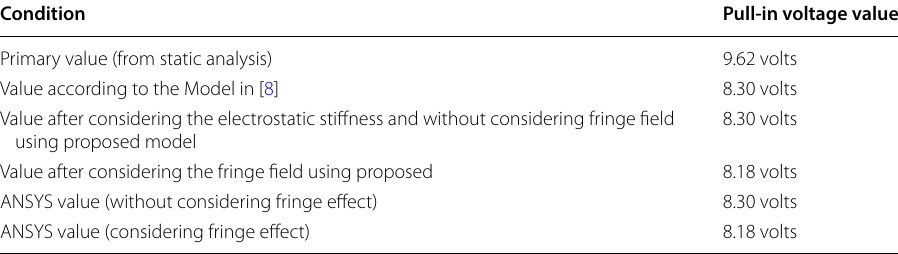
Table 2 Comparison between MATLAB and ANSYS results with and without fringe field Condition Pull-in voltage value Primary value (from static analysis)